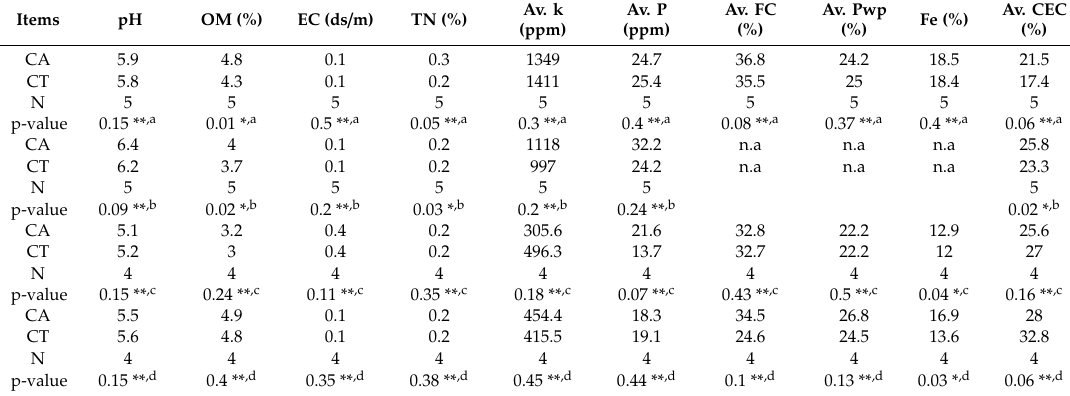
Table A1. A one tailed paired t-test for the average soil physico-chemical properties, where OM, EC, TN, Av. K, Av.P, Av. FC, Av.Pwp, Fe, and Av. CEC are organic matter, electrical conductivity, total